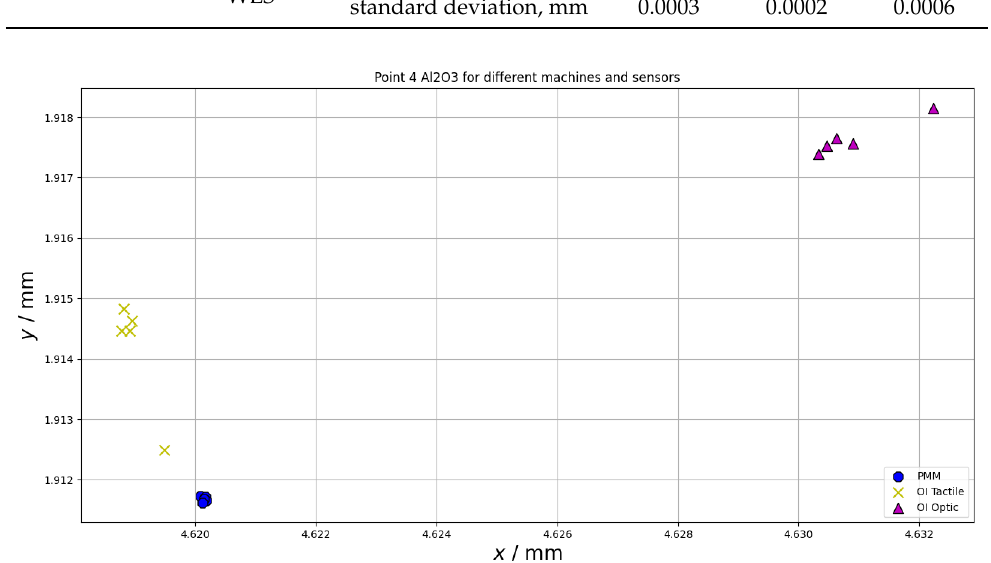
Figure 8. Repeatability of measuring point for chosen point at the equator of the sphere made of